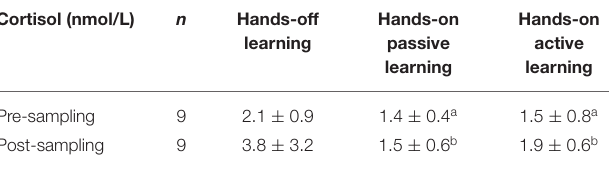
TABLE 3 | Combined immature donkey saliva concentrations of cortisol pre- and post-sampling in association with different student-donkey interactions during times 1 (week 2), 2 (weeks 5–8), and 3 (week 12) over three, 15-week periods. Cortisol (nmol/L) Hands-on